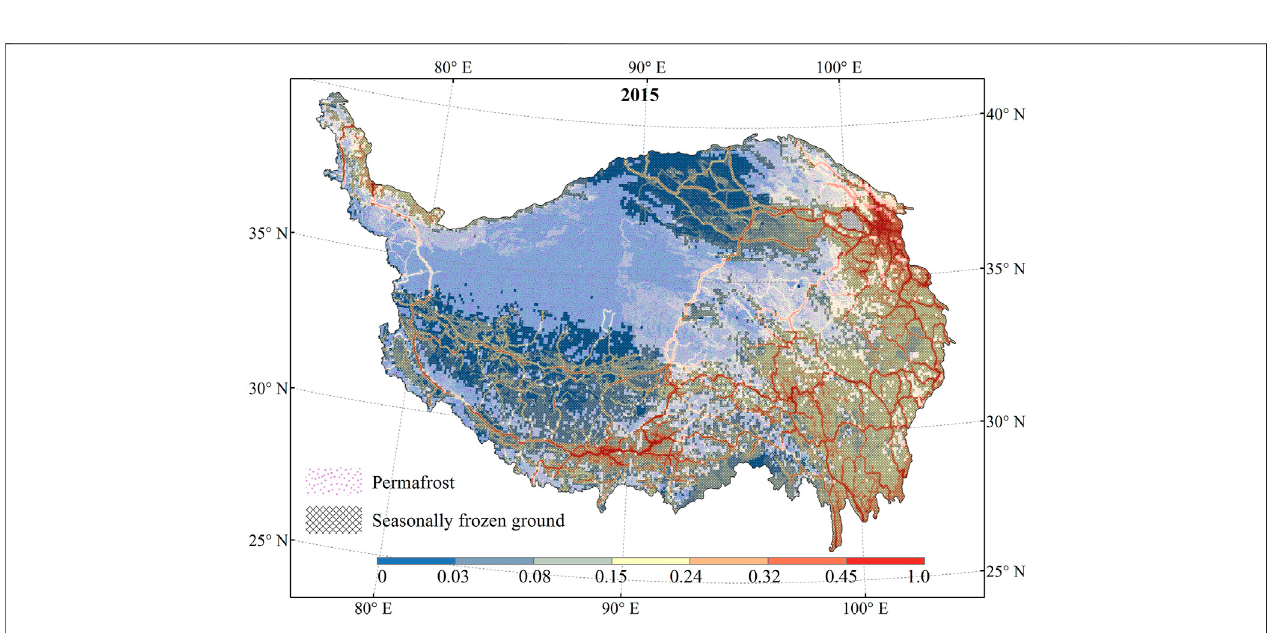
FIGURE 5 | Human activity intensity within the frozen ground in 2015.